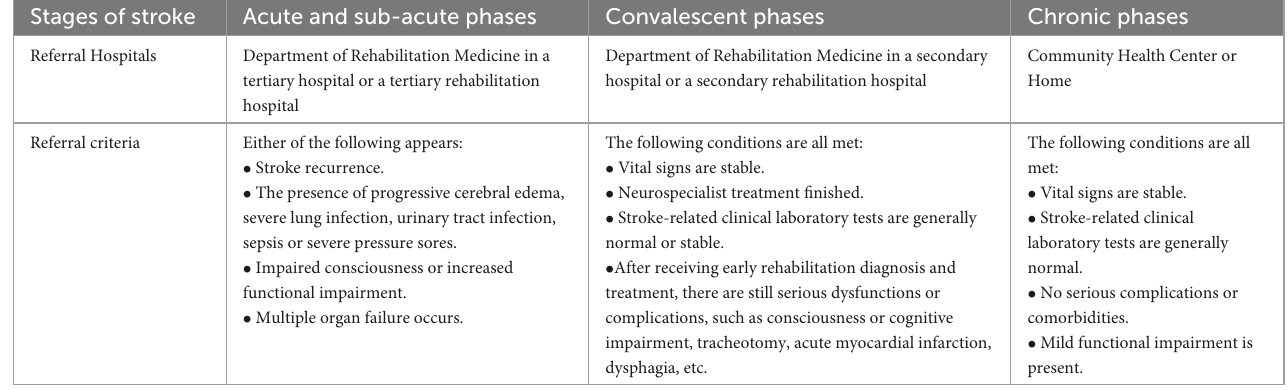
TABLE 1 Staged stroke referral